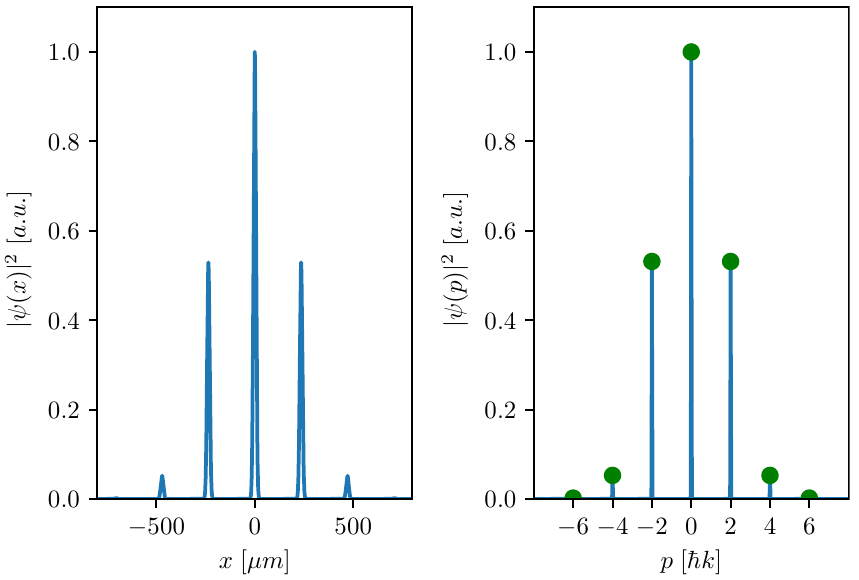
50 ω 1 µ s and a rectangular temporal r , τ = = 0 (cid:31) k and 25% in each of the | � 20 ms to clearly separate the wavepackets = 0.01 (cid:31) k. Numerical results of this =